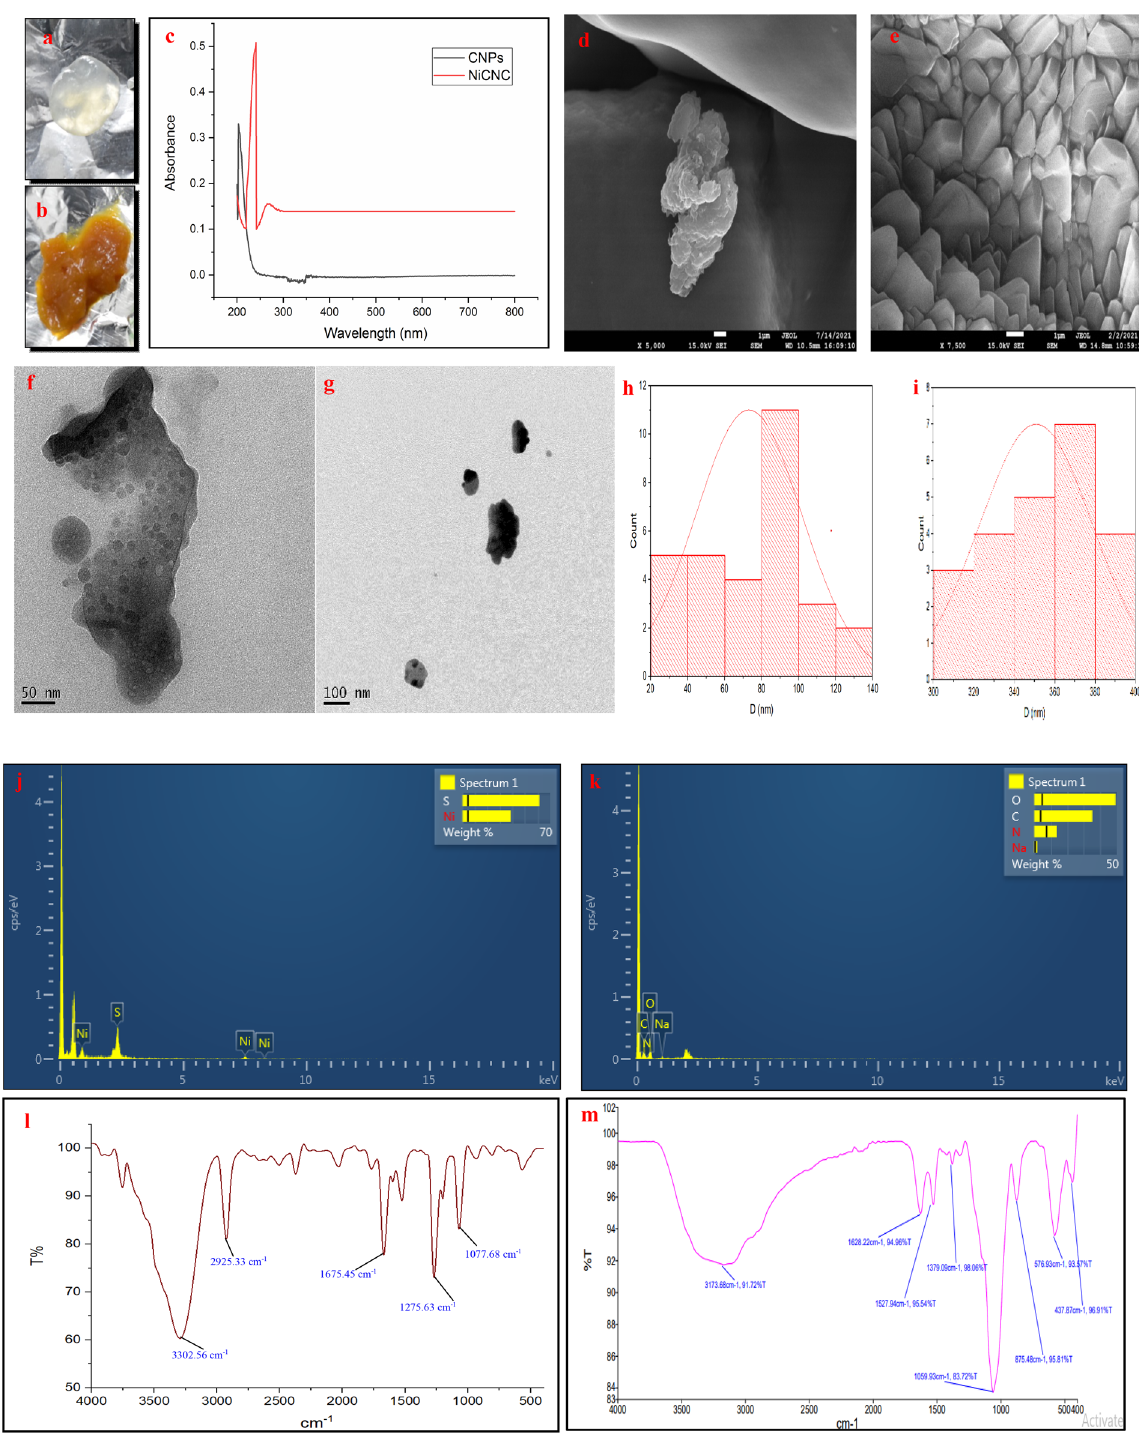
Figure 1. Nano-hydrogel images of ( a ) CNPs and ( b ) NiCNC obtained through Ionotropic Gelation Method; Characterization of CNPs and NiCNC through ( c ) UV–Vis spectra of CNPs and NiCNC; FE-SEM analysis of ( d ) CNPs and ( e ) NiCNC; HRTEM analysis of ( f ) CNPs and ( g ) NiCNC; Particle size distribution histogram of ( h ) CNPs and ( i ) NiCNC; EDXS analysis of ( j ) NiCNC and ( k ) CNPs and FT-IR analysis of ( l ) CNPs and ( m )